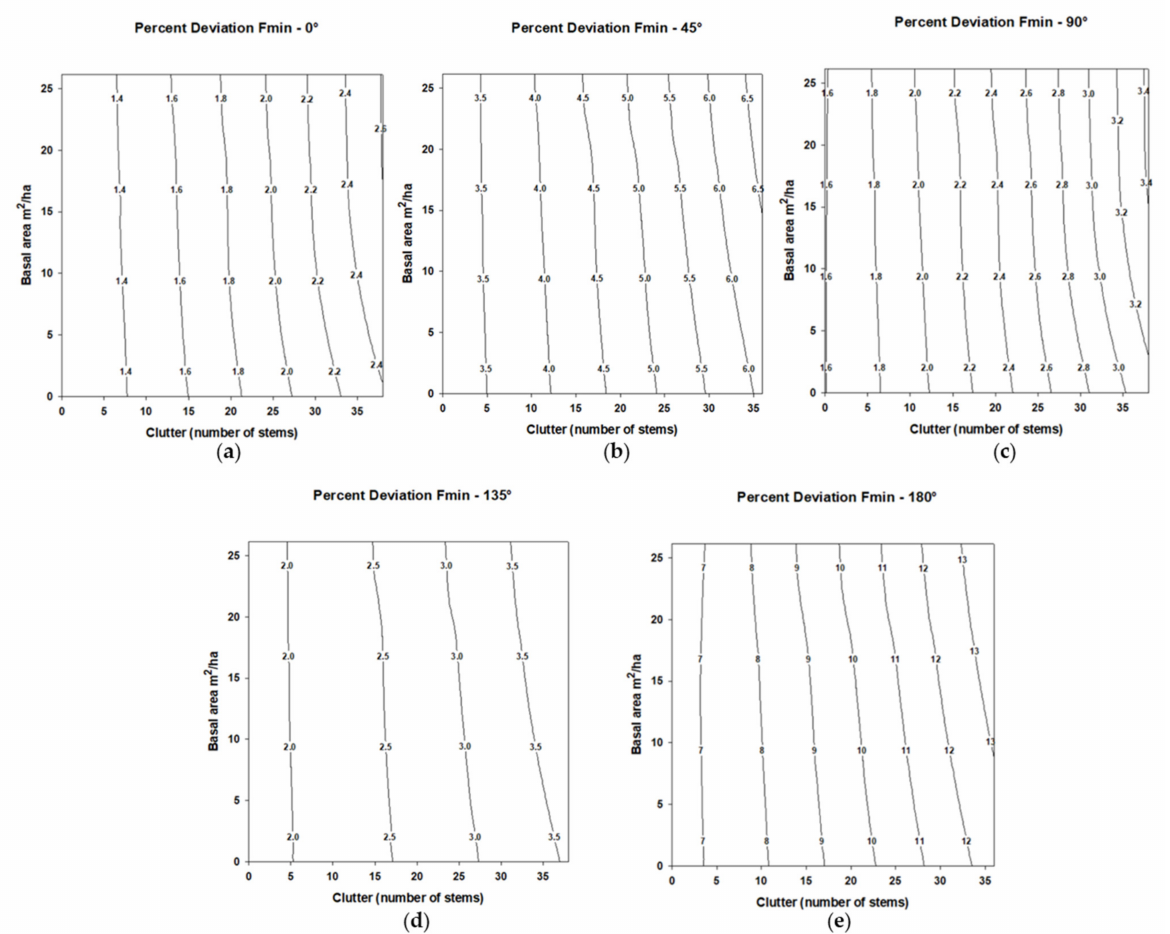
Figure 4. Contour graph for generalized linear model results of synthetic bat echolocation playback response within an anechoic chamber displaying the percent deviation on the minimum frequency (Fmin) call parameter in relation to stem density (stem count) and basal area (m 2 /ha) for detector angles ( a ) 0 ◦ , ( b ) 45 ◦ , ( c ) 90 ◦ , ( d ) 135 ◦ , and ( e ) 180 ◦ , Blacksburg, VA, USA, 2016 (see text for